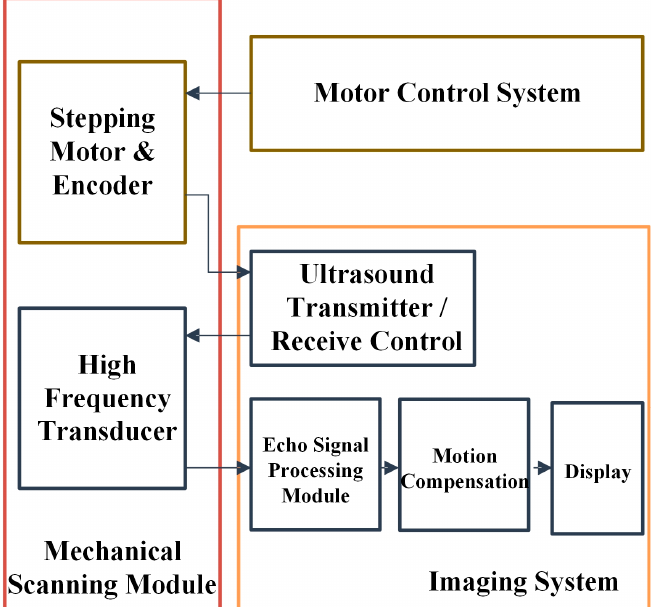
Figure 4. The schematic diagram of the mechanical scanning ultrasound imaging system. A 500 P/R encoder (20HS2806A4, Omron) was used to record the rotation position of the motor in real time to obtain the precise positioning of the transducer. Because the stepping motor rotates 1 turn and the transducer is scanned reciprocating once, the mechanical scanning positioning accuracy of the system can reach 60 µ m. The fabricated mechanical scanning imaging system is shown in Figure 5. In the experiment, both the imaging target (tungsten wire phantom or blood flow phantom) and the front end of the mechanical scanning module (mainly the transducer part) were immersed in a sink to test the relevant imaging performance. Regarding the operating temperature of the system, because its application goal is for clinical diagnosis, the experiments were carried out at room temperature. Tested by sink heating below 40 degrees Celsius, since the mechanical scanning module and transducer have good temperature resistance, the performance of the system was very stable.